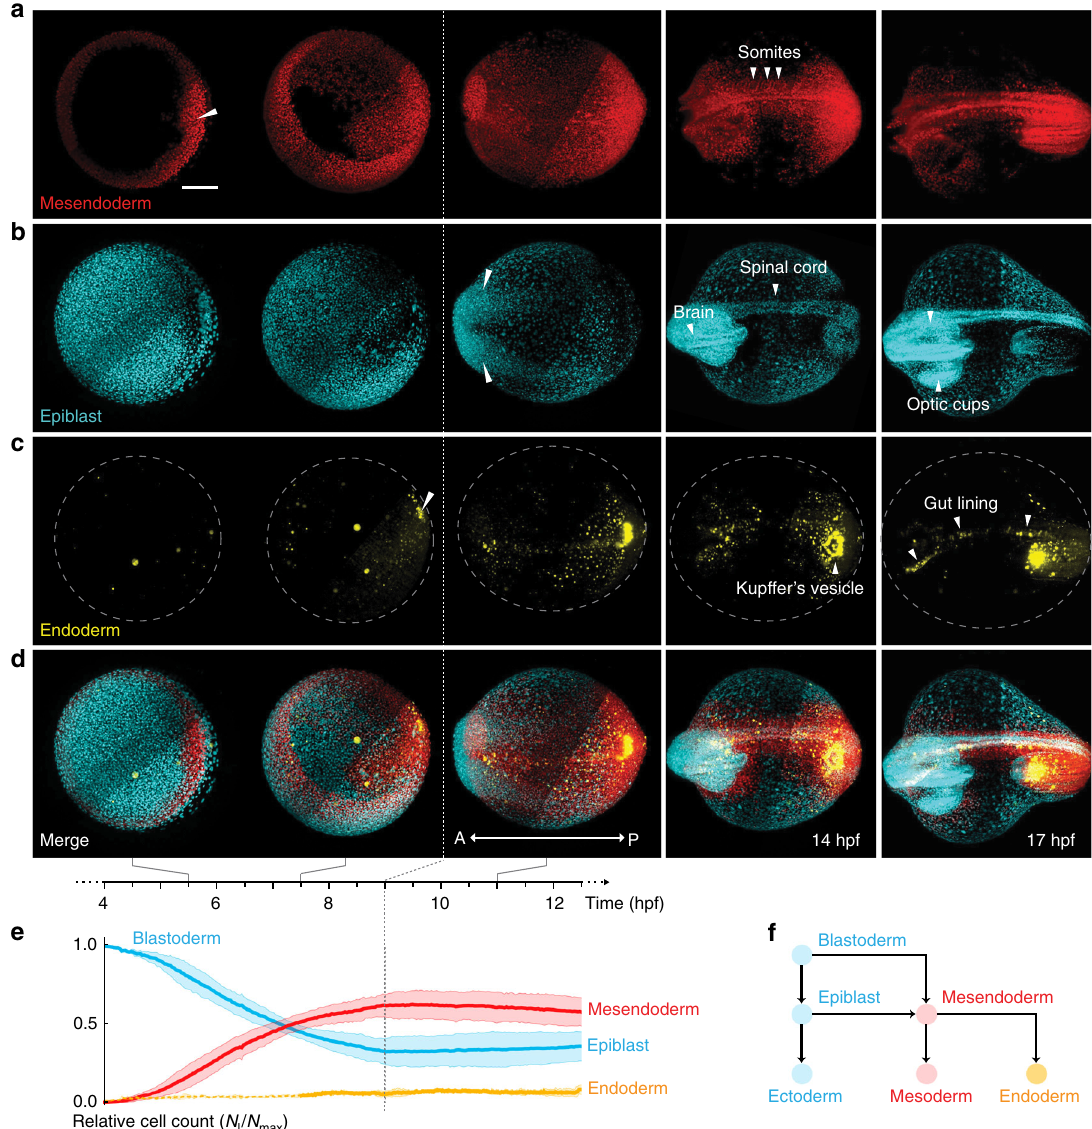
Fig. 1 In toto imaging of germlayer speci fi cation and dynamics. a – c Formation and dynamics of mesendoderm (red), epiblast (cyan), and endoderm (yellow) cells spanning 4 – 17 hpf. n = 3 where all embryos resembled the images shown here. a Mesendoderm speci fi cation begins at the dorsal lip (white triangle), spreads around the germ ring and converges towards the dorsal midline, forming the somites and notochord (white triangles). b Epiblast cells converge towards the anterior (white triangles) leading to formation of brain, spinal cord and optic cups. c Endoderm speci fi cation begins at the dorsal shield (white triangle) with the DFCs, followed by rest of the endoderm, which forms the gut lining and Kupffer ’ s vesicle upon dorsal convergence. Yellow spots in the fi rst two images is non-speci fi c signal. d Merge of all three germlayers. Scale bar: 200 μ m. A: anterior, P: posterior. e Mean relative cell numbers ( n = 3) for epiblast (blue), mesendoderm (red) and endoderm (yellow). Bands correspond to 1.96 · standard error. Dashed part of the yellow line indicates the period before endoderm speci fi cation. f Schematic explaining germlayer speci fi cation showing blastoderm differentiating into mesendoderm and epiblast. Mesendoderm further differentiates into mesoderm and